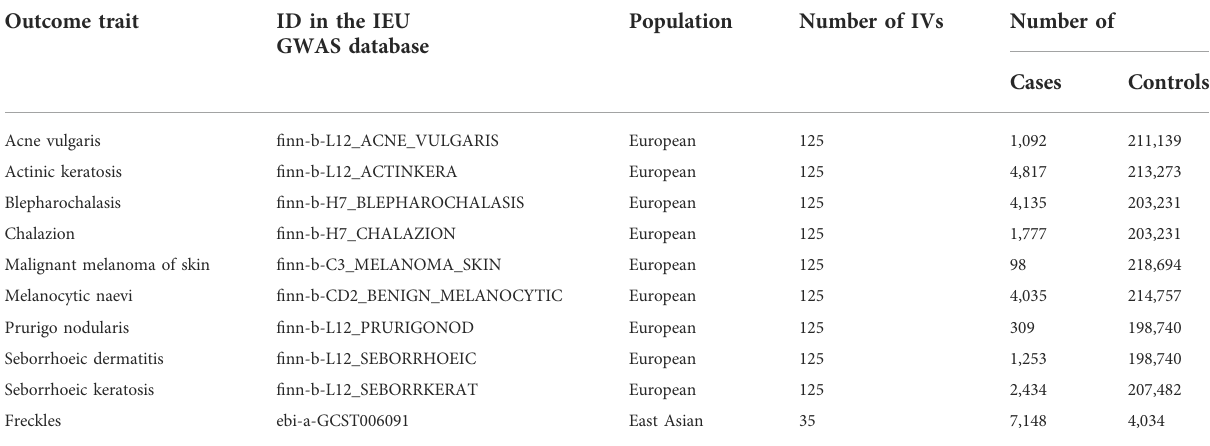
TABLE 1 Summary of the outcome GWAS in the discovery